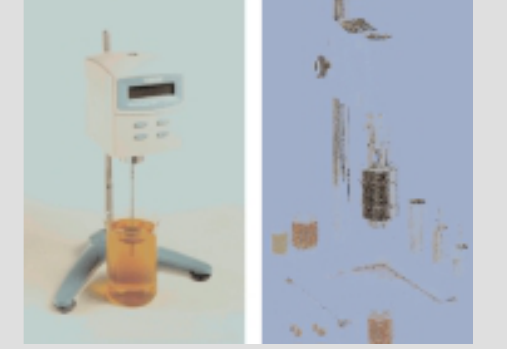
Figure 4 (left): Haake Visco- testers VT 6/7 (left) and the concentric-cylinder VT 550. Figure 5 (right): Typical flow curve for a structured liquid, showing the low shear plateau, the power-law shear-thining region and the high shear rate viscosity